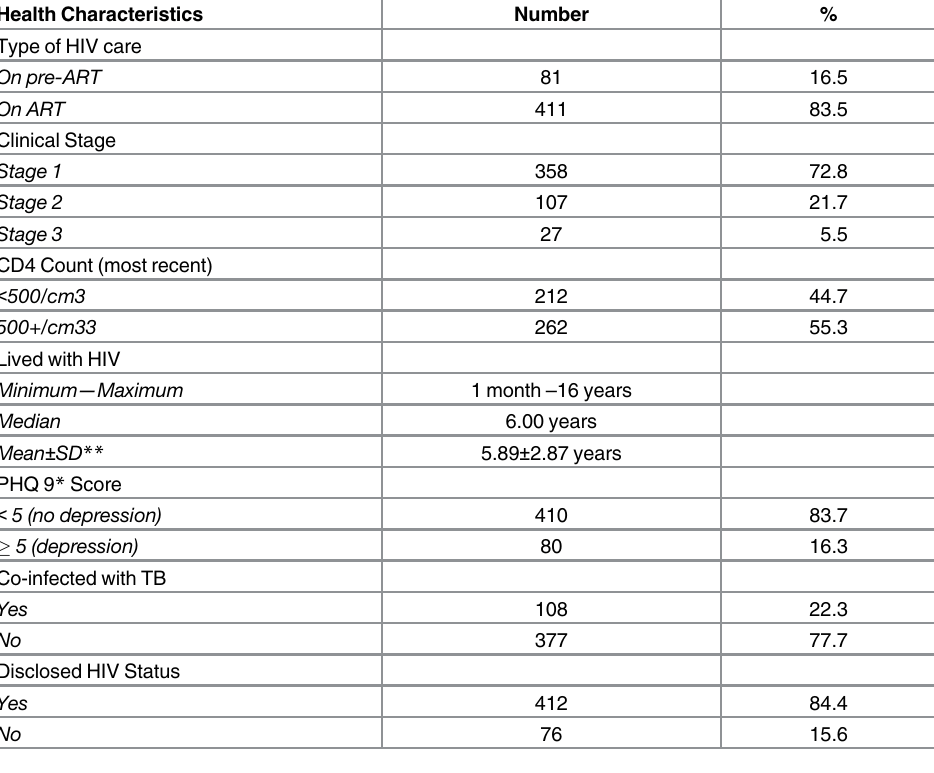
Table 2. Health Characteristics of the Participants, Wolaita Zone,